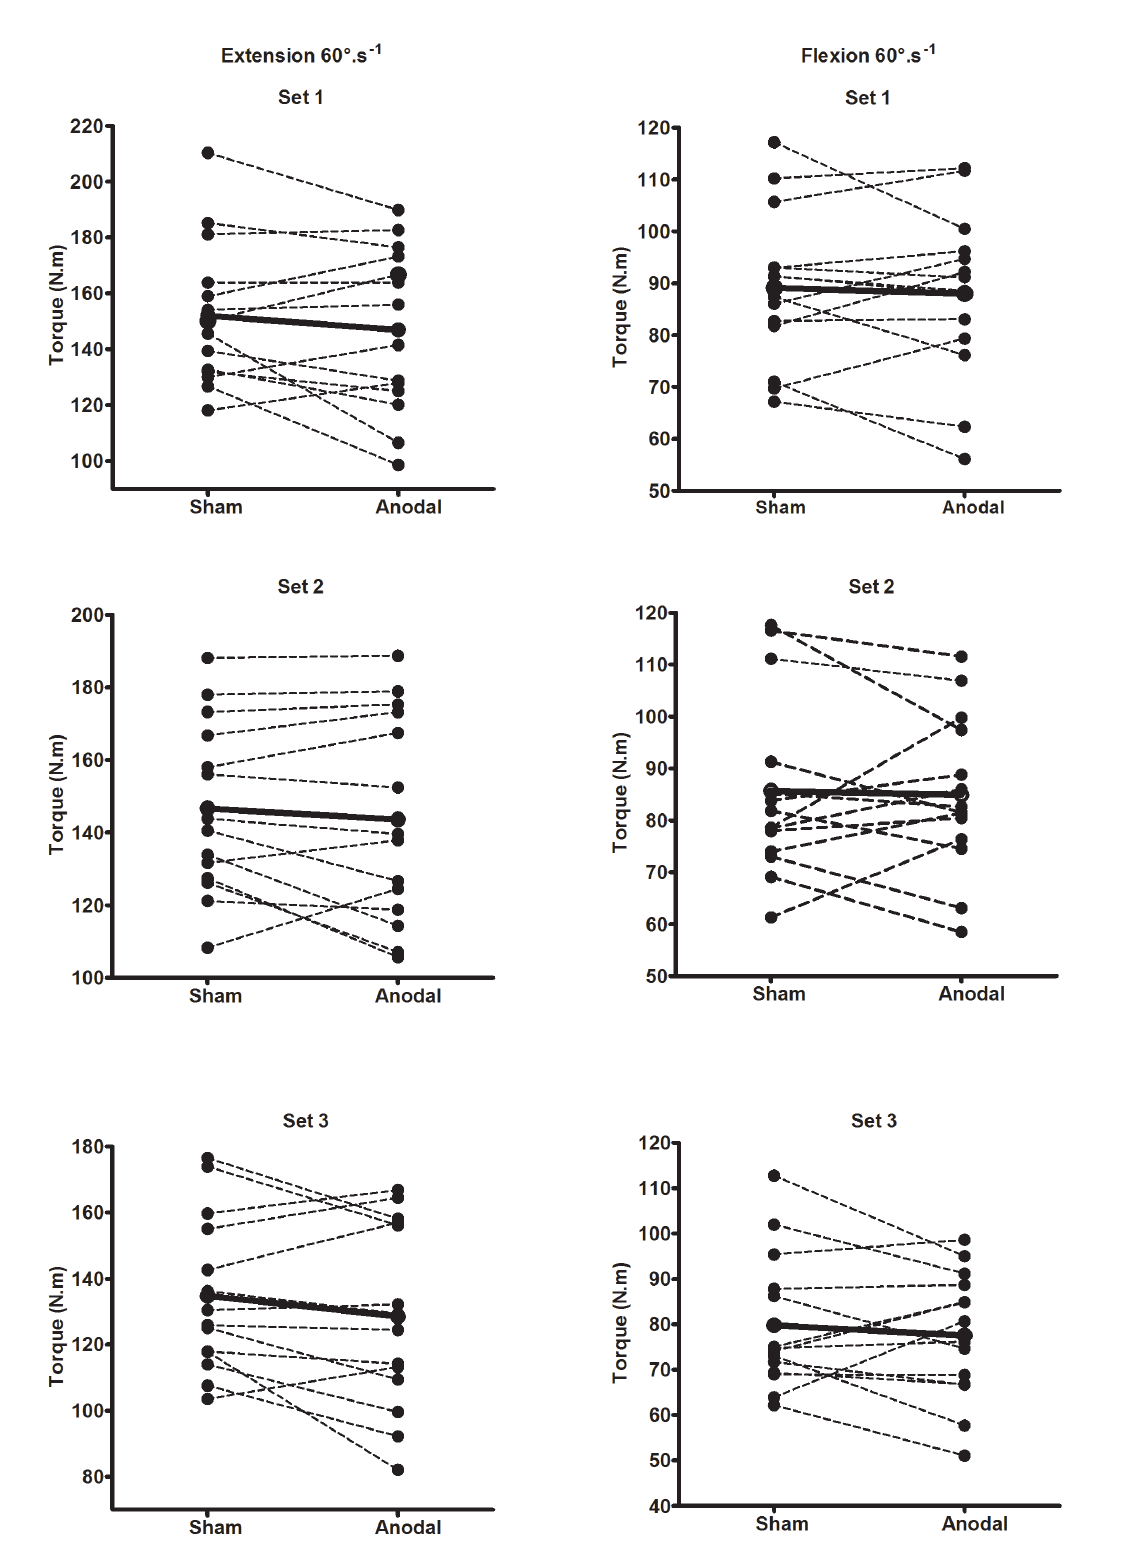
Figure 3. Individual (dashed lines) and mean (solid line) values of muscle torque per sets within knee extension and flexion after anodal tDCS and sham condition ( n =14). 2-way ANOVA with repeated measures did not detected significant differences between anodal and sham tDCS for muscle torque per sets [ F (5,78) = 1.16; P = .33]. tDCS = Transcranial direct current